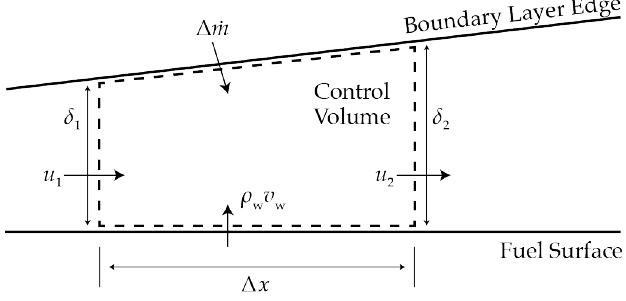
Figure A1. Sketch of the control volume for the momentum integral